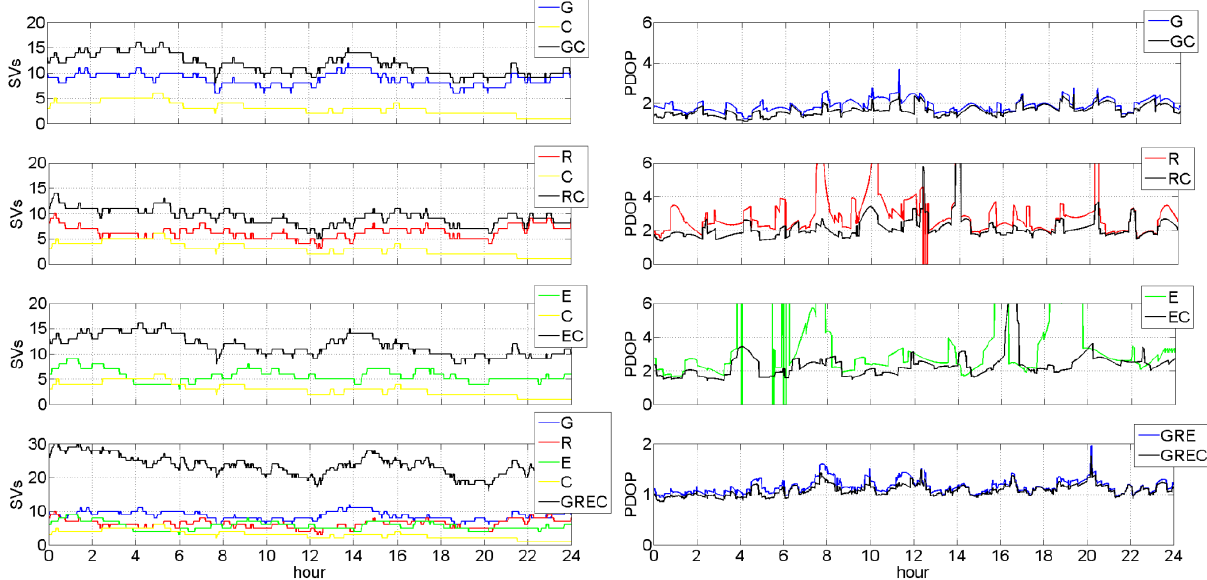
Figure 7. Number of observed SVs and PDOP coefficients on AUBG station (day 1 in 2021 Figure 7 . Number of observed SVs and PDOP coefficients on AUBG station (day 1 in 2021 year).